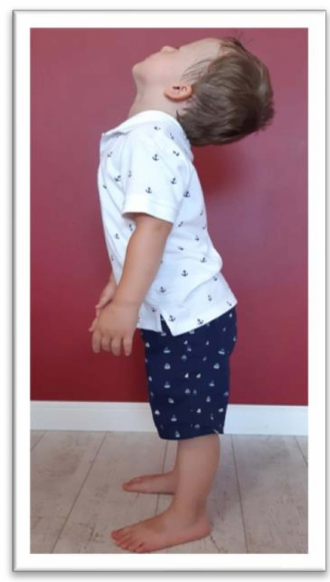
Figure 3. Position for the examination of STNR flexion.